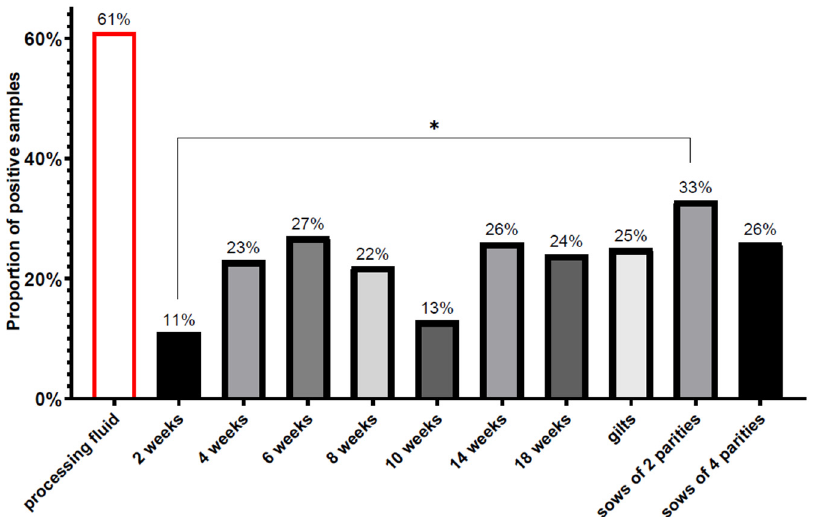
Figure 3. Percentages of PCV3-positive processing fluids and serum sample pools of different age groups. The statistical comparison of the PCV3 prevalence of each age group was performed by Fisher’s exact test. The asterisk above the columns represents the statistically significant difference (*: p < 0.05).